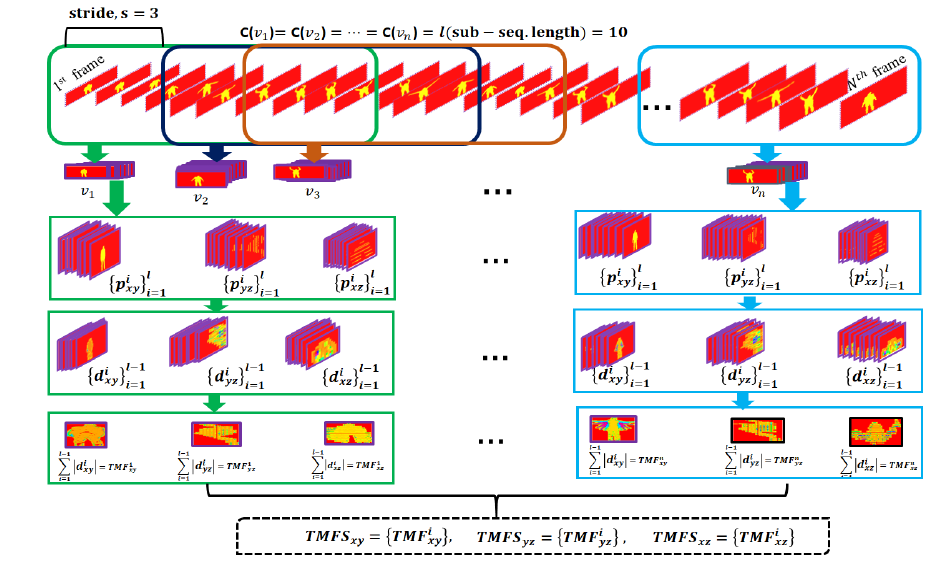
Figure 1. A step-by-step example of temporal motion frame sequence